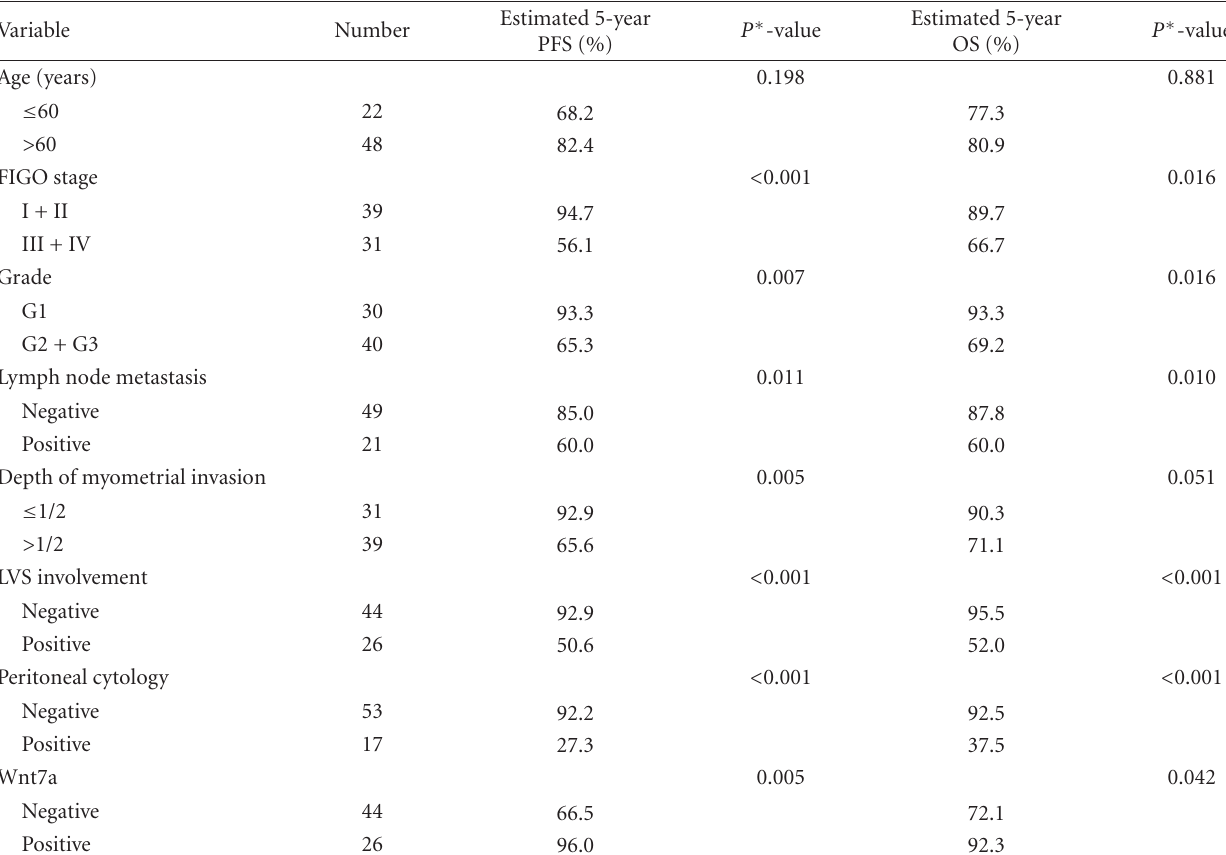
FIGO: International Federation of Gynecology and Obstertics; LVS: lymph vascular space; PFS: progression-free survival; OS: overall survival and ∗ log-rank